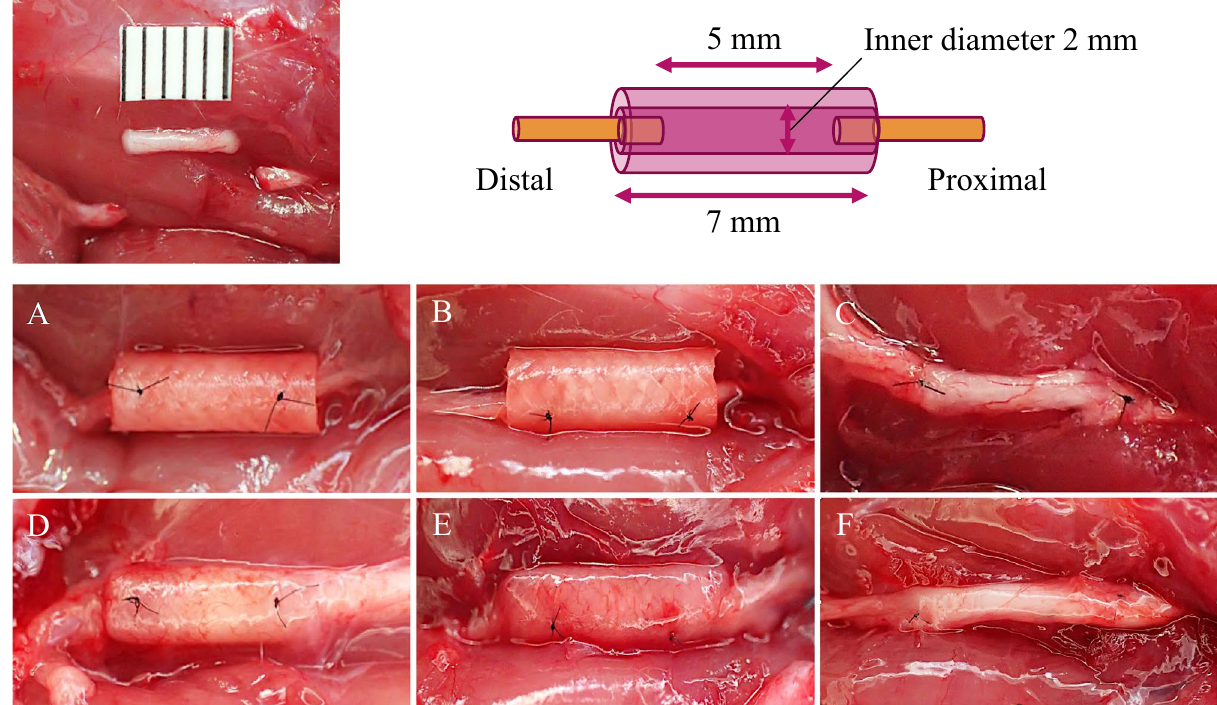
Figure 2. Intraoperative gross findings in the rat sciatic nerve transection experimental model. Reconstructed with the nerve conduit alone (control group, A and D ), the nerve conduit coated with